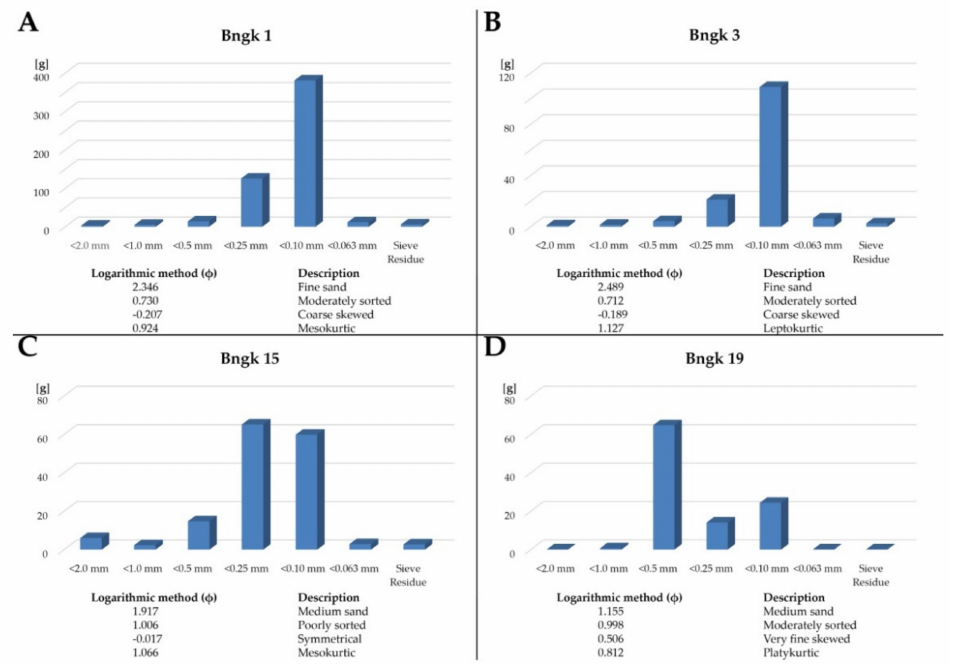
Figure 4. Grain size distribution in tailings samples; ( A ) fine-grained, moderately sorted tailings from Belinyu; ( B ) fine-grained, moderately sorted tailings from Jurung; ( C ) medium-grained, poorly sorted tailings from Lubuk; ( D ) medium-grained, moderately sorted tailings from